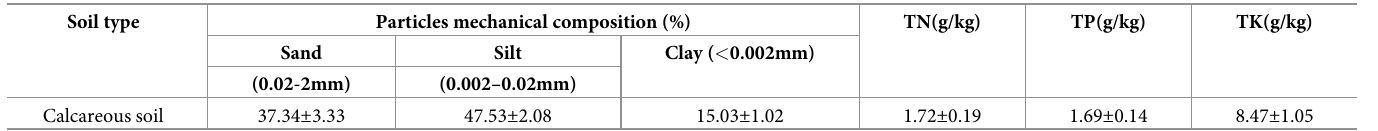
Table 1. Basic properties of the test soil.